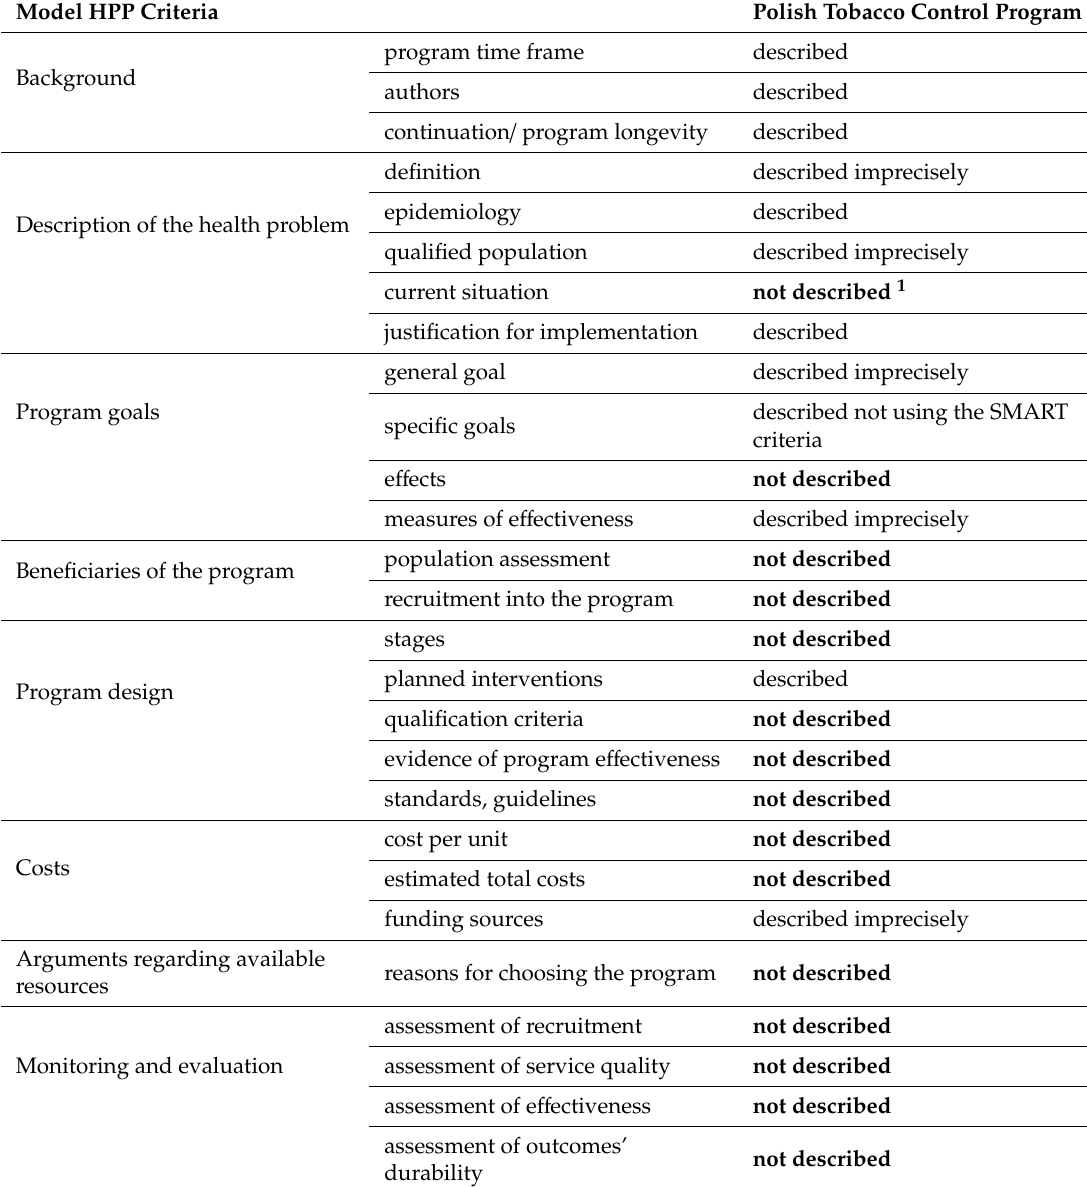
Table 1. Comparison of the content of the Polish Tobacco Control Program for years 2014–2018 with the AHTAPol guidelines–model health policy program